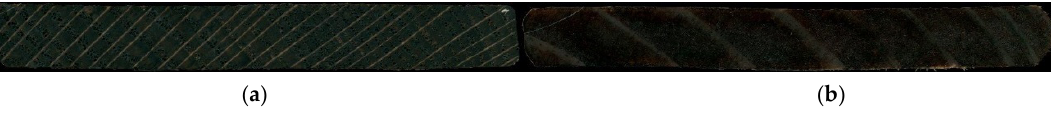
Figure 6. Penetration of PF resin into red oak ( a ) and radiata pine ( b ) panels treated with 30% PF ‐ HALS resin. Note that the intensity of the blue ‐ black colour caused by the reaction of ferric chloride with PF resin is less pronounced in the rays and earlywood of oak, and the latewood of pine, suggesting that penetration of the sample by PF resin was not uniform. Table 4. Weight gains as a result of treatment, and thickness swelling of PF resin treated red oak and radiata pine panels immersed in water for 72 h.